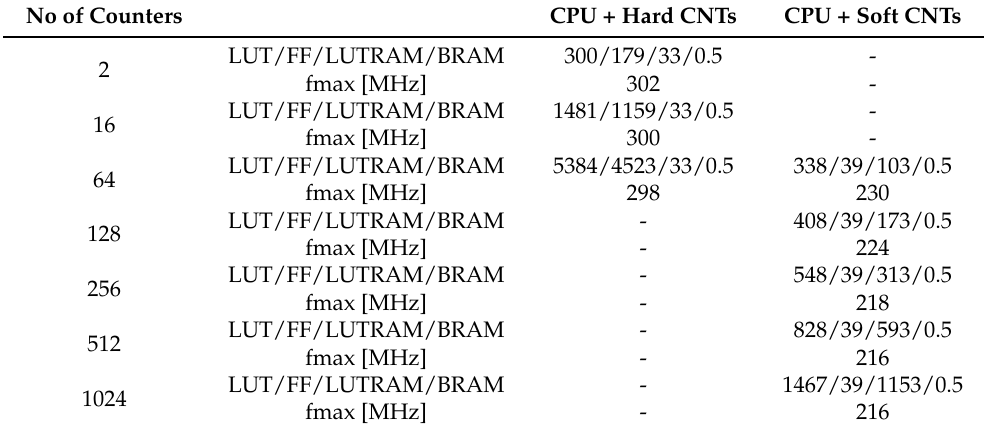
Table 2. Result for CPU with